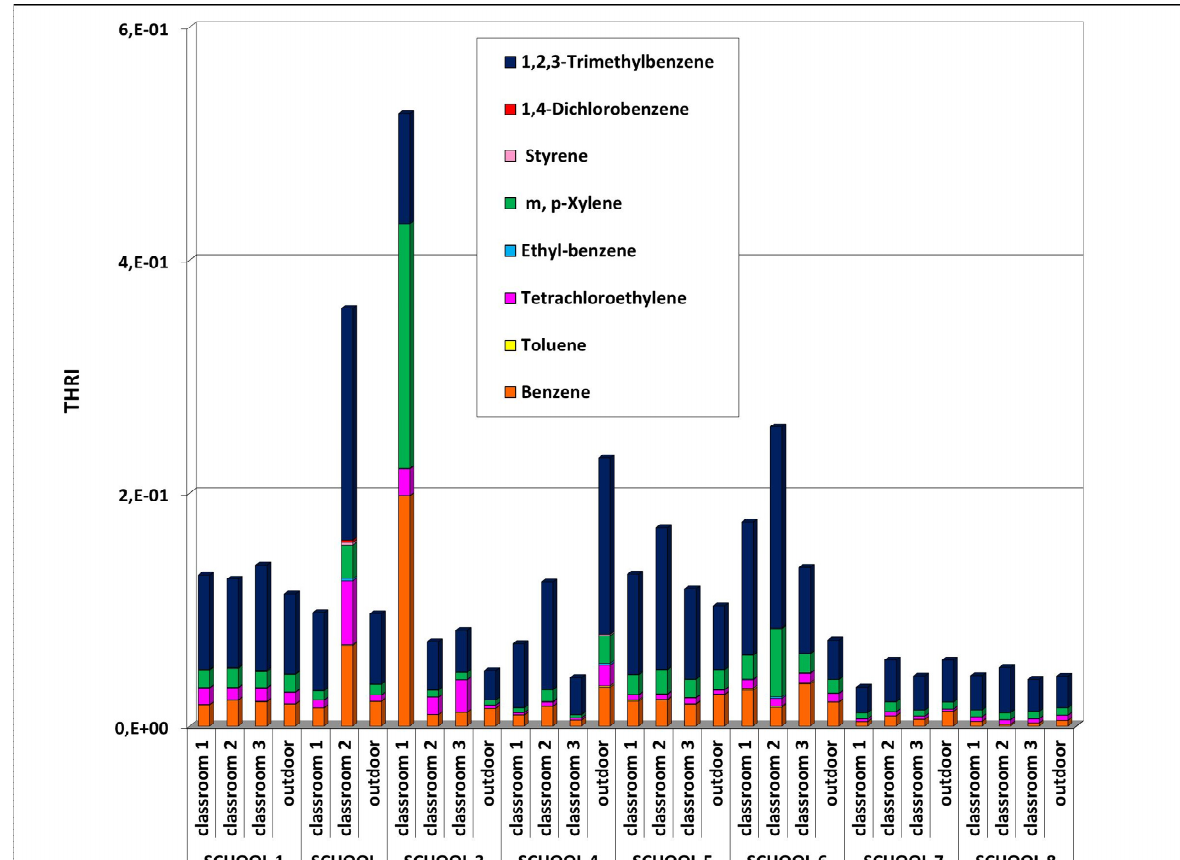
Figure 9. THRI values for each monitored site.